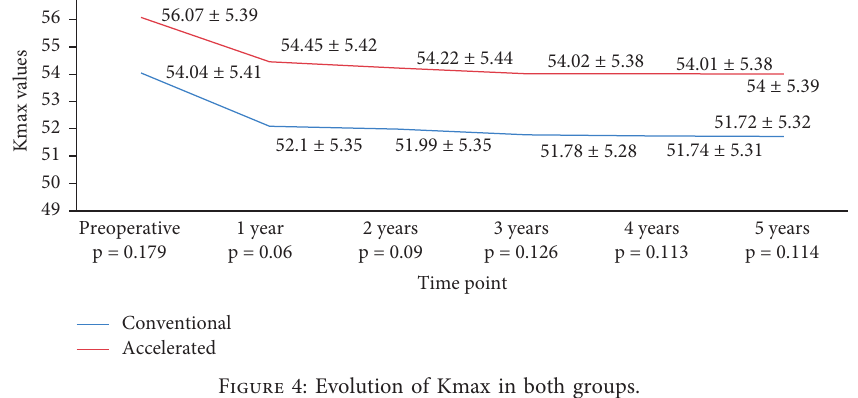
Figure 4: Evolution of Kmax in both